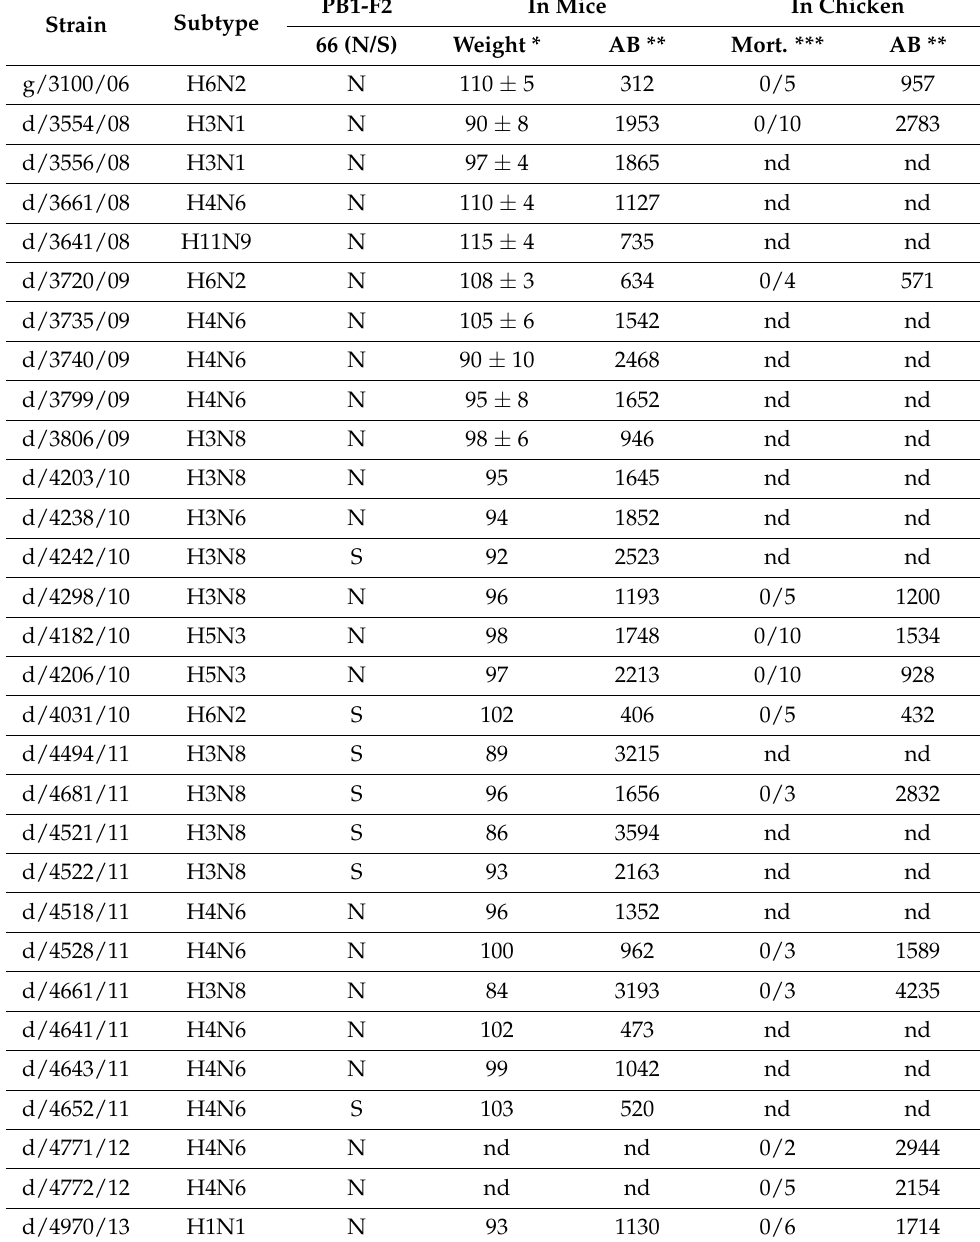
Table 4. Pathogenicity and immunogenicity of isolates for mice and